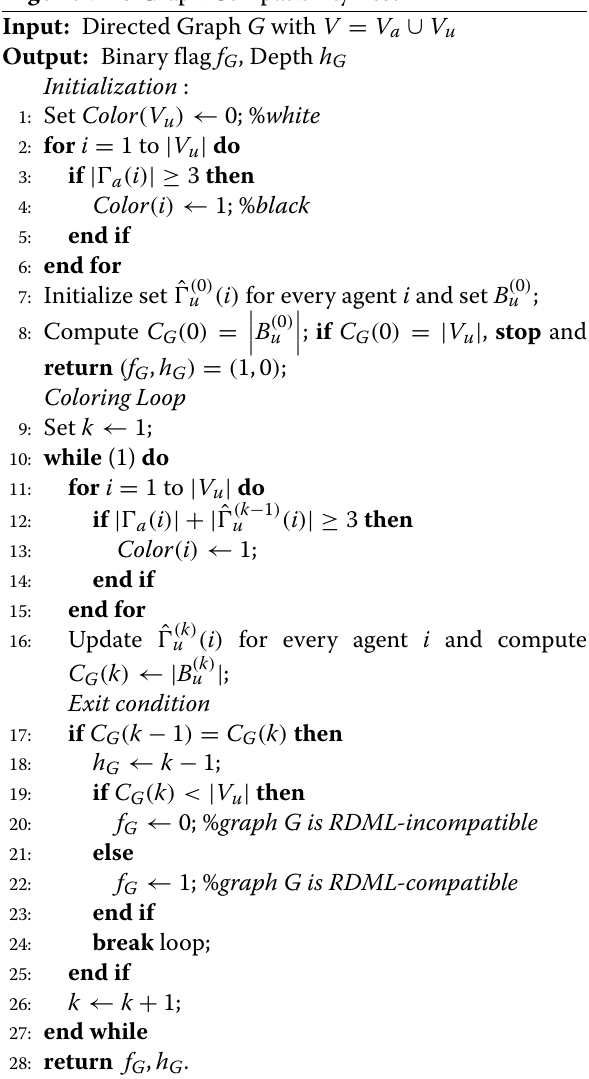
Algorithm 3 Graph Compatibility